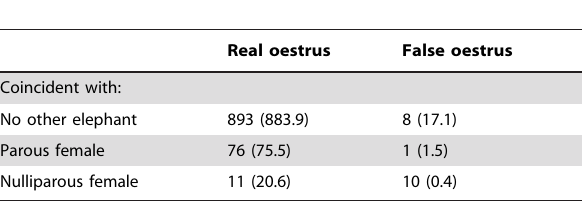
Table 1. Occurrence of oestrus events coincident with